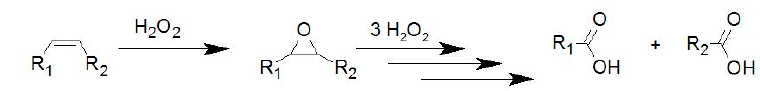
Scheme 2. Tungsten-catalyzed oxidative cleavage reaction of aliphatic olefins using hydrogen peroxide.